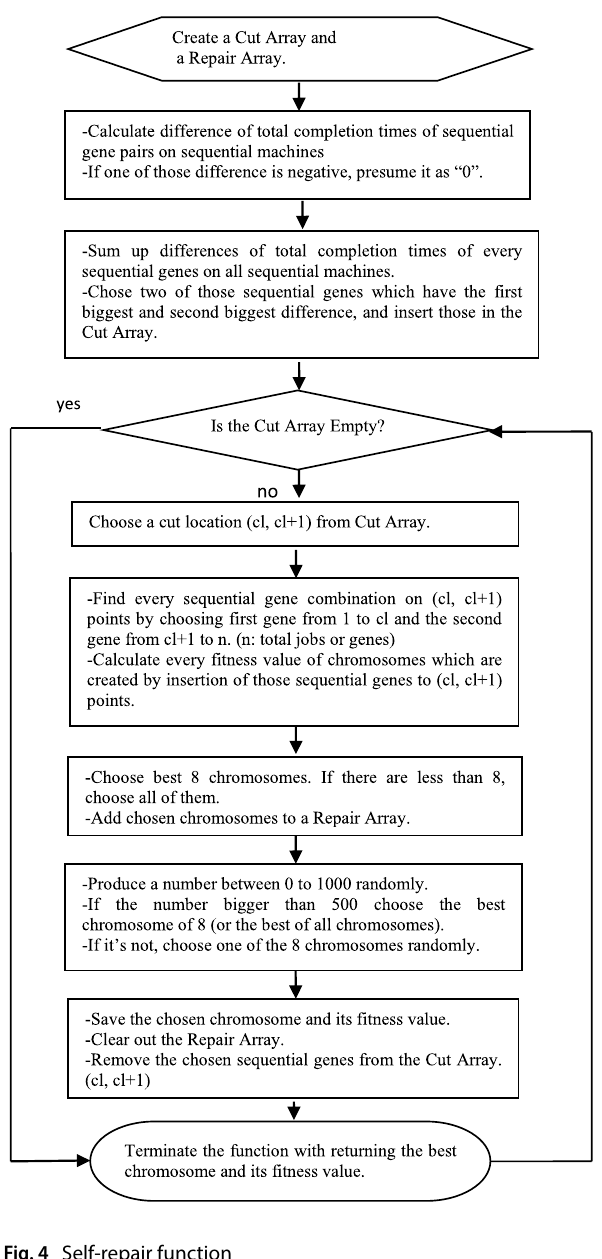
Fig. 4 Self-repair function